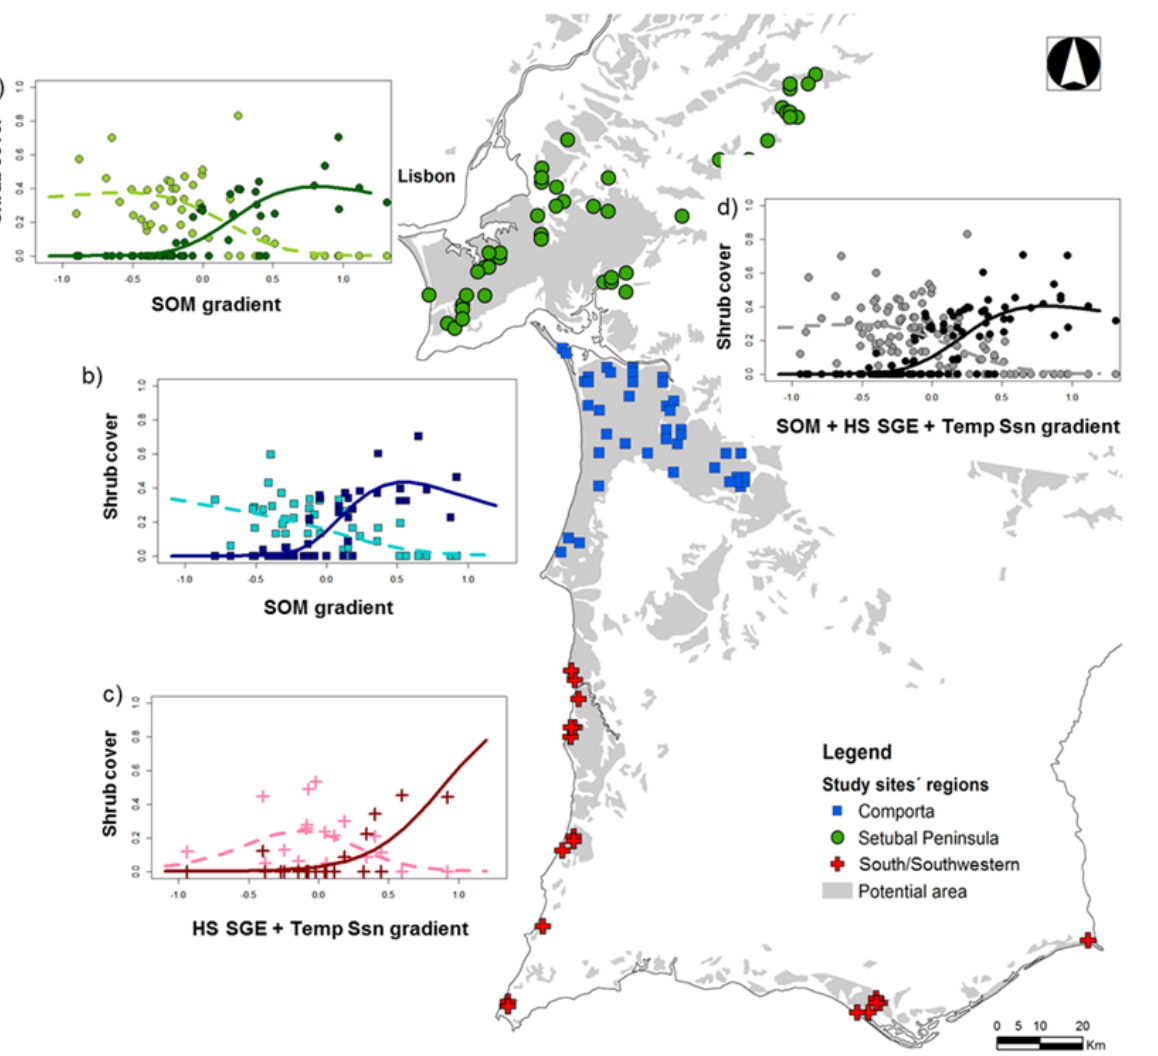
Figure 2. Relationships between the cover of Stauracanthus genistoides (in pale dashed lines) and Ulex australis (in dark continuous lines) and the environmental gradients defined by the first axis of the ordination based on scrub cover in (a) Setúbal Peninsula region, circles, (b) Comporta region, squares, (c) South/southwestern region (SSW), crosses and (d) all sites. The main trends of the relationships were identified by Generalized Additive Models of the binomial family. SOM: Soil organic matter; HS SGE: Habitat suitability of S. genistoides ; and Temp Ssn: Temperature